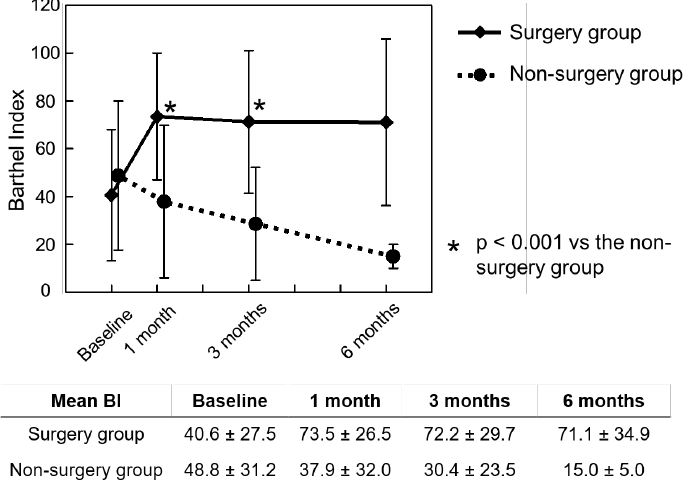
Figure 3. Chronological changes in the BI preoperatively and at 1, 3 and 6 months after study commencement; BI: Barthel Index.